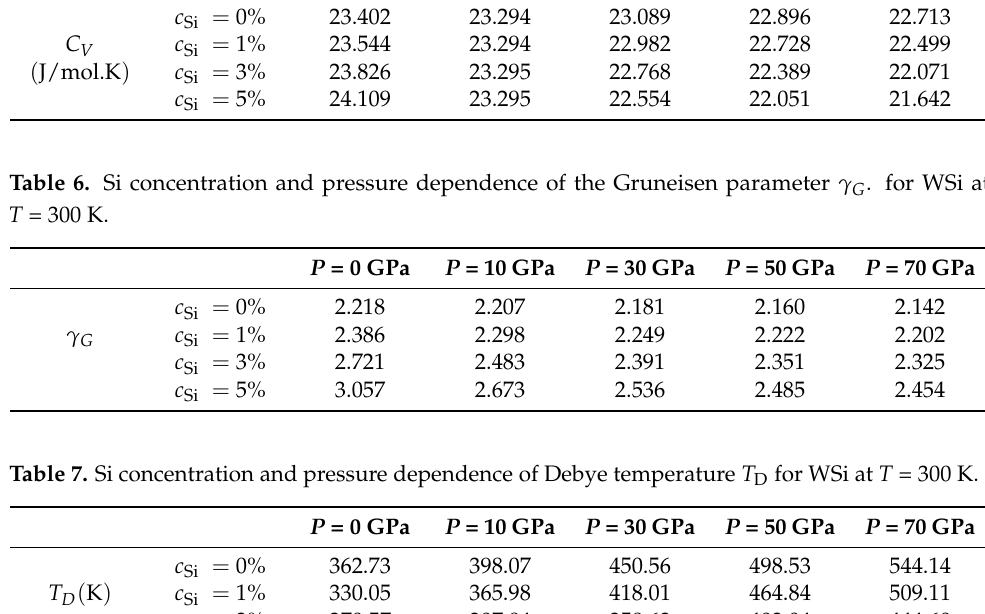
(cid:0) (cid:1) 10 − 30 m 3 for WSi at